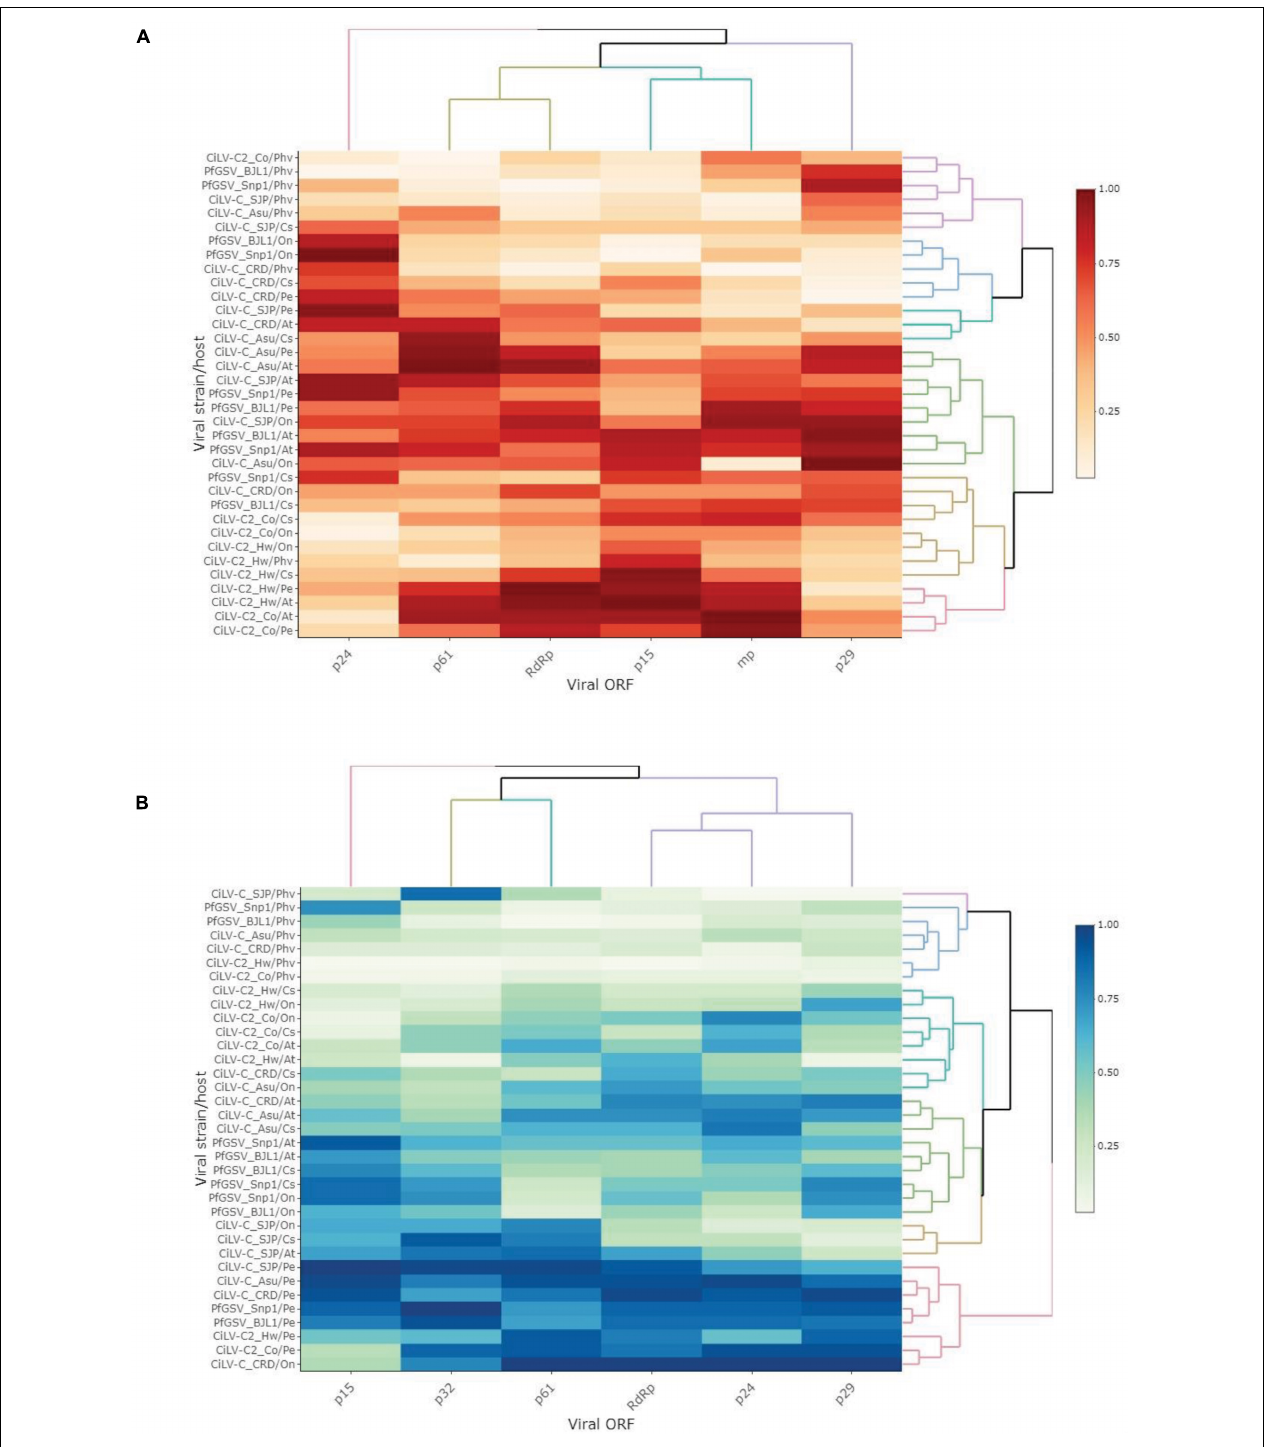
FIGURE 5 | Codon adaption of cilevirus ORFs. Heatmaps representing the values of COUSIN (A) and the RCDI/eRCDI (B) , respectively, of every ORF across cilevirus isolates. For the sake of comparative analyses, COUSIN and the RCDI/eRCDI values have been obtained simulating the interaction of all viruses with the same hypothetical host range. Codon usage database of host plants and values of ENc, COUSIN, and RCDI are shown in Supplementary Tables 3 , 4 . The heat map was drawn in Rstudio (Rstudio_team, 2021) using the “heatmapply” function (Galili et al., 2018). Both COUSIN and RCDI/eRCDI values were transformed using the “percentize” method and dist_method = “Euclidean” and hclust_method = “complete” were selected. Darker red and light green to white represent the best values in each heat map, respectively. At, Arabidopsis thaliana ; Cs, Citrus × sinensis ; Pe, Passiflora edulis ; On, Oncidium sp.; and Phv, Phaseolus vulgaris .